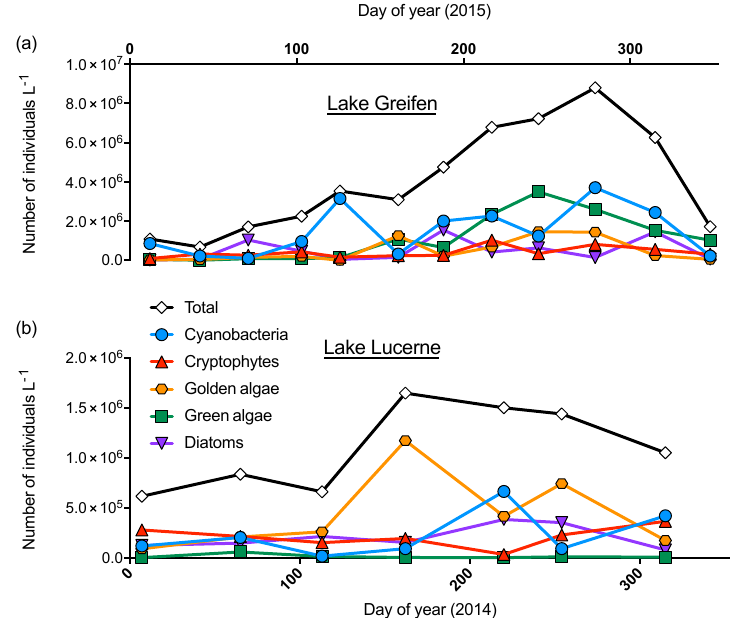
Figure 4. Cell counts (individuals per liter) for all algae and for most common taxa of algae in (a) Lake Greifen throughout 2015 and (b) Lake Lucerne in 2014. The scale of the y axis differs between the two panels. Data from long-term monitoring program are run by the department of Aquatic Ecology at